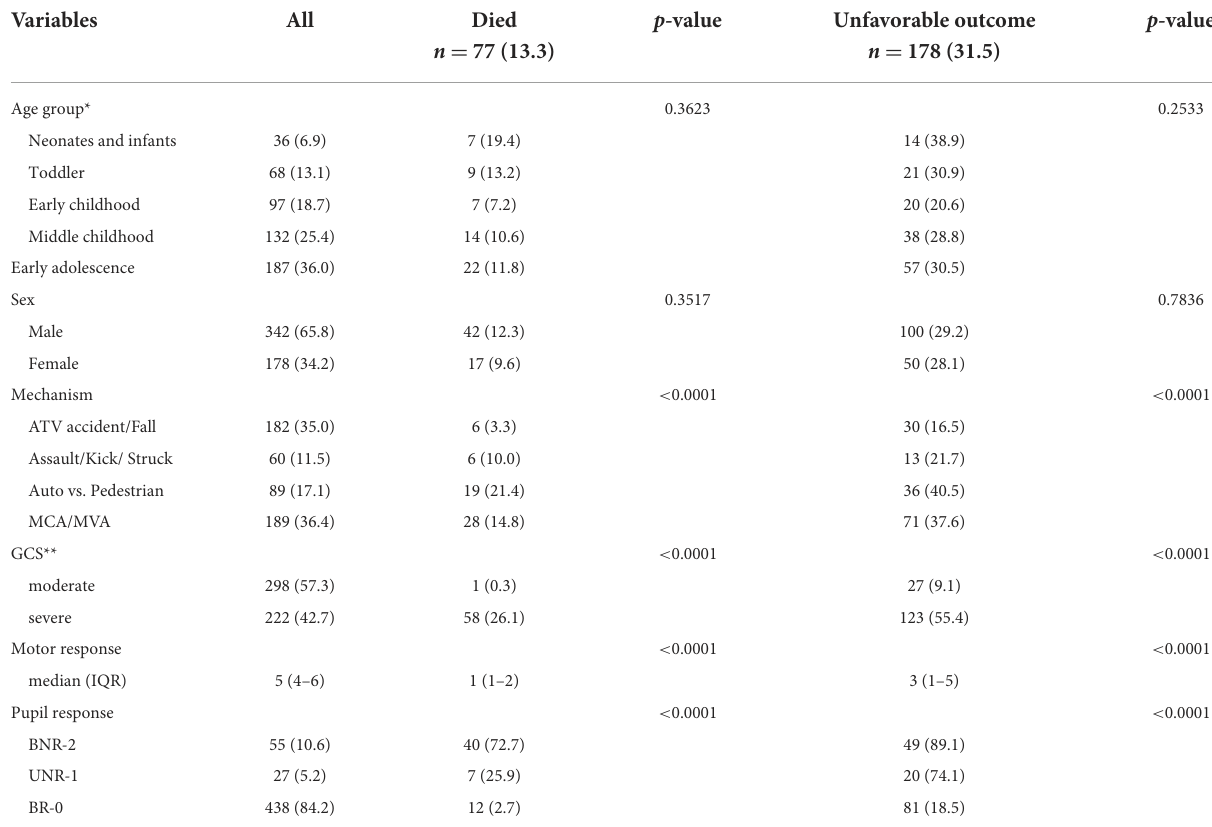
TABLE 1 Cohort characteristics by outcomes (GOS-E) at 6 months follow-up ( n =